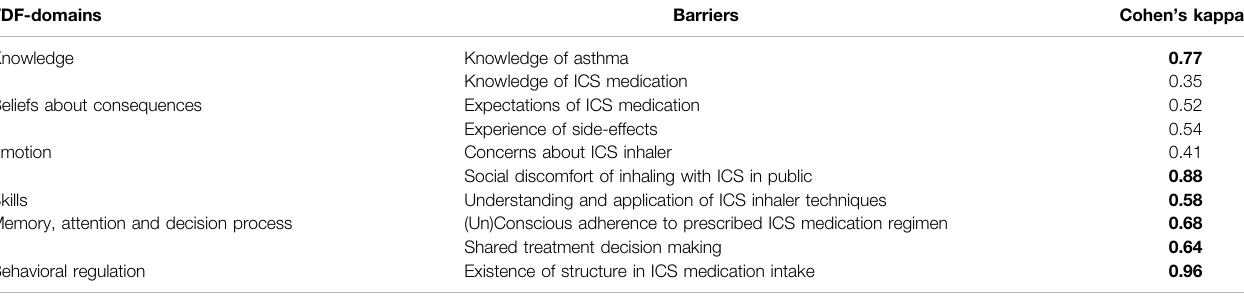
TABLE 5 | The inter-rater reliability test results of the appraisals on the presence/absence of self-management barriers according to the interview coding ’ s of two analysts. TDF-domains